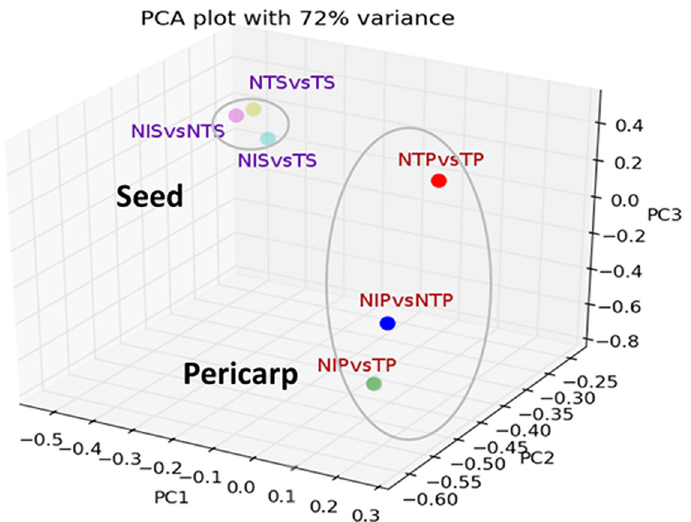
Fig 3. Principal component analysis (PCA) showing the variability (72% variance) of DEGs of cotton in pericarp and seed tissue in response to infection by toxigenic and atoxiganic strains of A . flavus . Expression of genes under different experimental conditions in seed (small oval) and pericarp (large oval) were distinct with the variability of expression higher in pericarp compared to seed. PC1, PC2 and PC3 explained 32%, 24% and 16% of the total